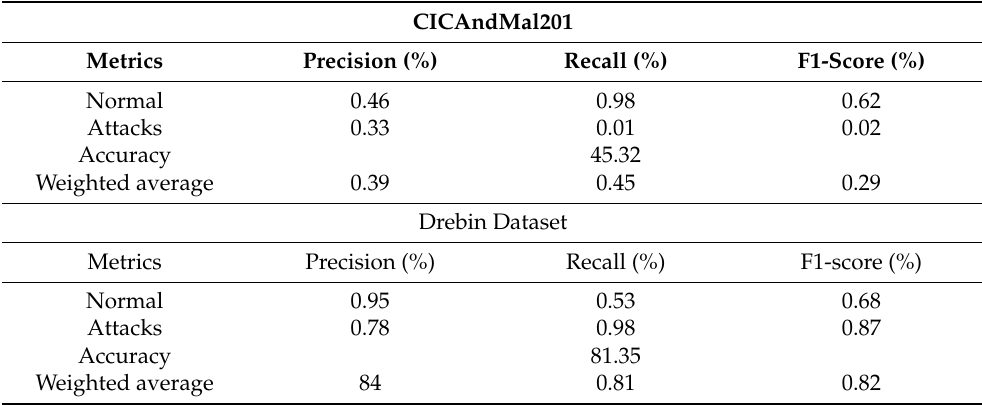
Table 7. Results of the LDA method.